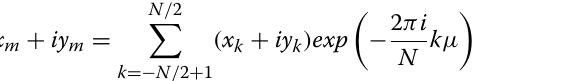
where N is the total number of descriptors; k is the descriptor number; N is the total number of points describing the particle; m is the index number of a point on the particle and i denotes an imaginary